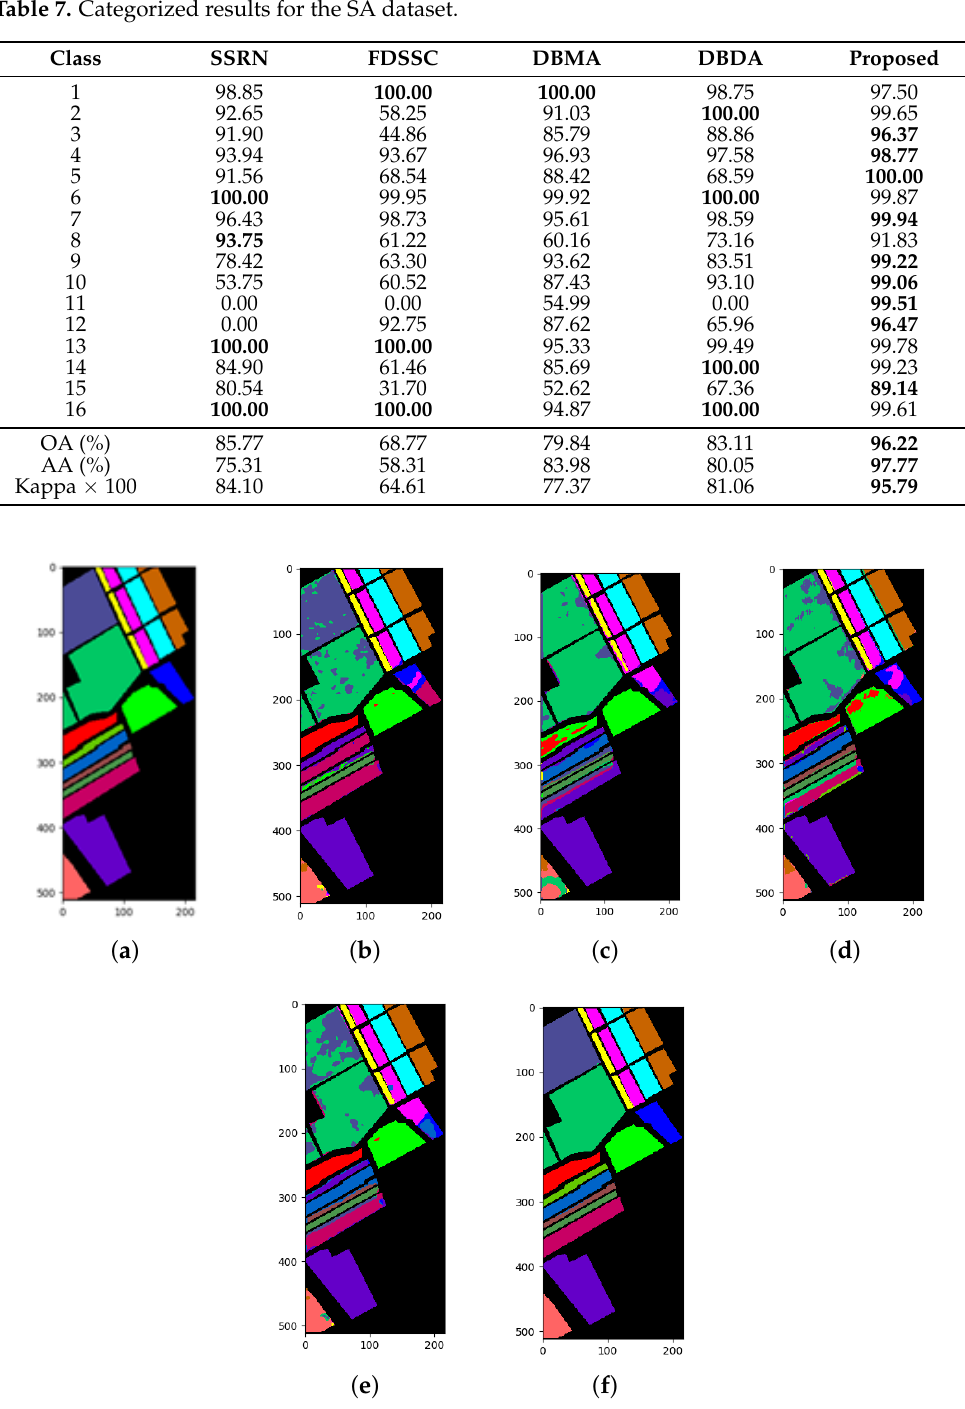
Figure 6. Classification maps for the SA dataset: ( a ) ground truth (GT); ( b – f ) results from the different algorithms. ( a ) GT; ( b ) SSRN; ( c ) FDSSC; ( d ) DBMA; ( e ) DBDA; ( f )